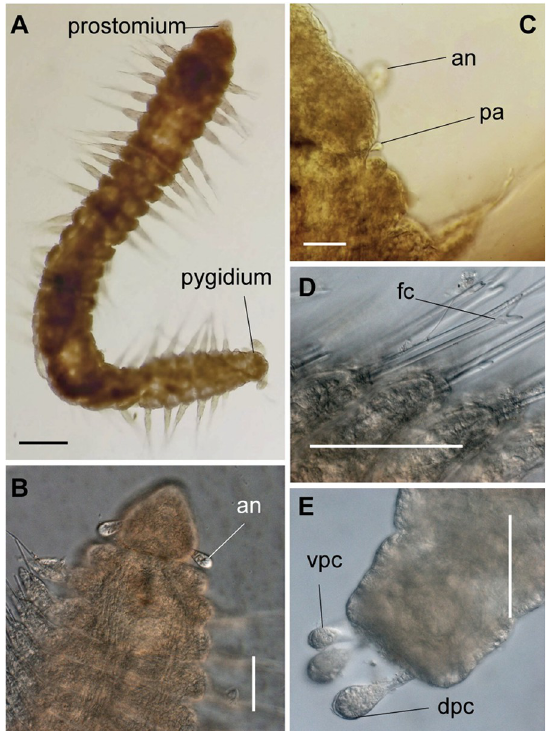
Fig 13. Meiodorvillea hartmanae sp. nov. (A) complete specimen, dorsal view; (B) anterior region, dorsal view; (C) anterior region, ventral view; (D) parapodia with furcate chaeta; (E) pygidium, dorsal view. Abbreviations: an = antenna; dpc = dorsal pygidial cirrus; fc = furcate chaeta; pa = palp; vpc = ventral pygidial cirrus. Scale bars: (A,B) = 100 μ m; (C) = 31.25 μ m; (D,E) = 88 μ m.